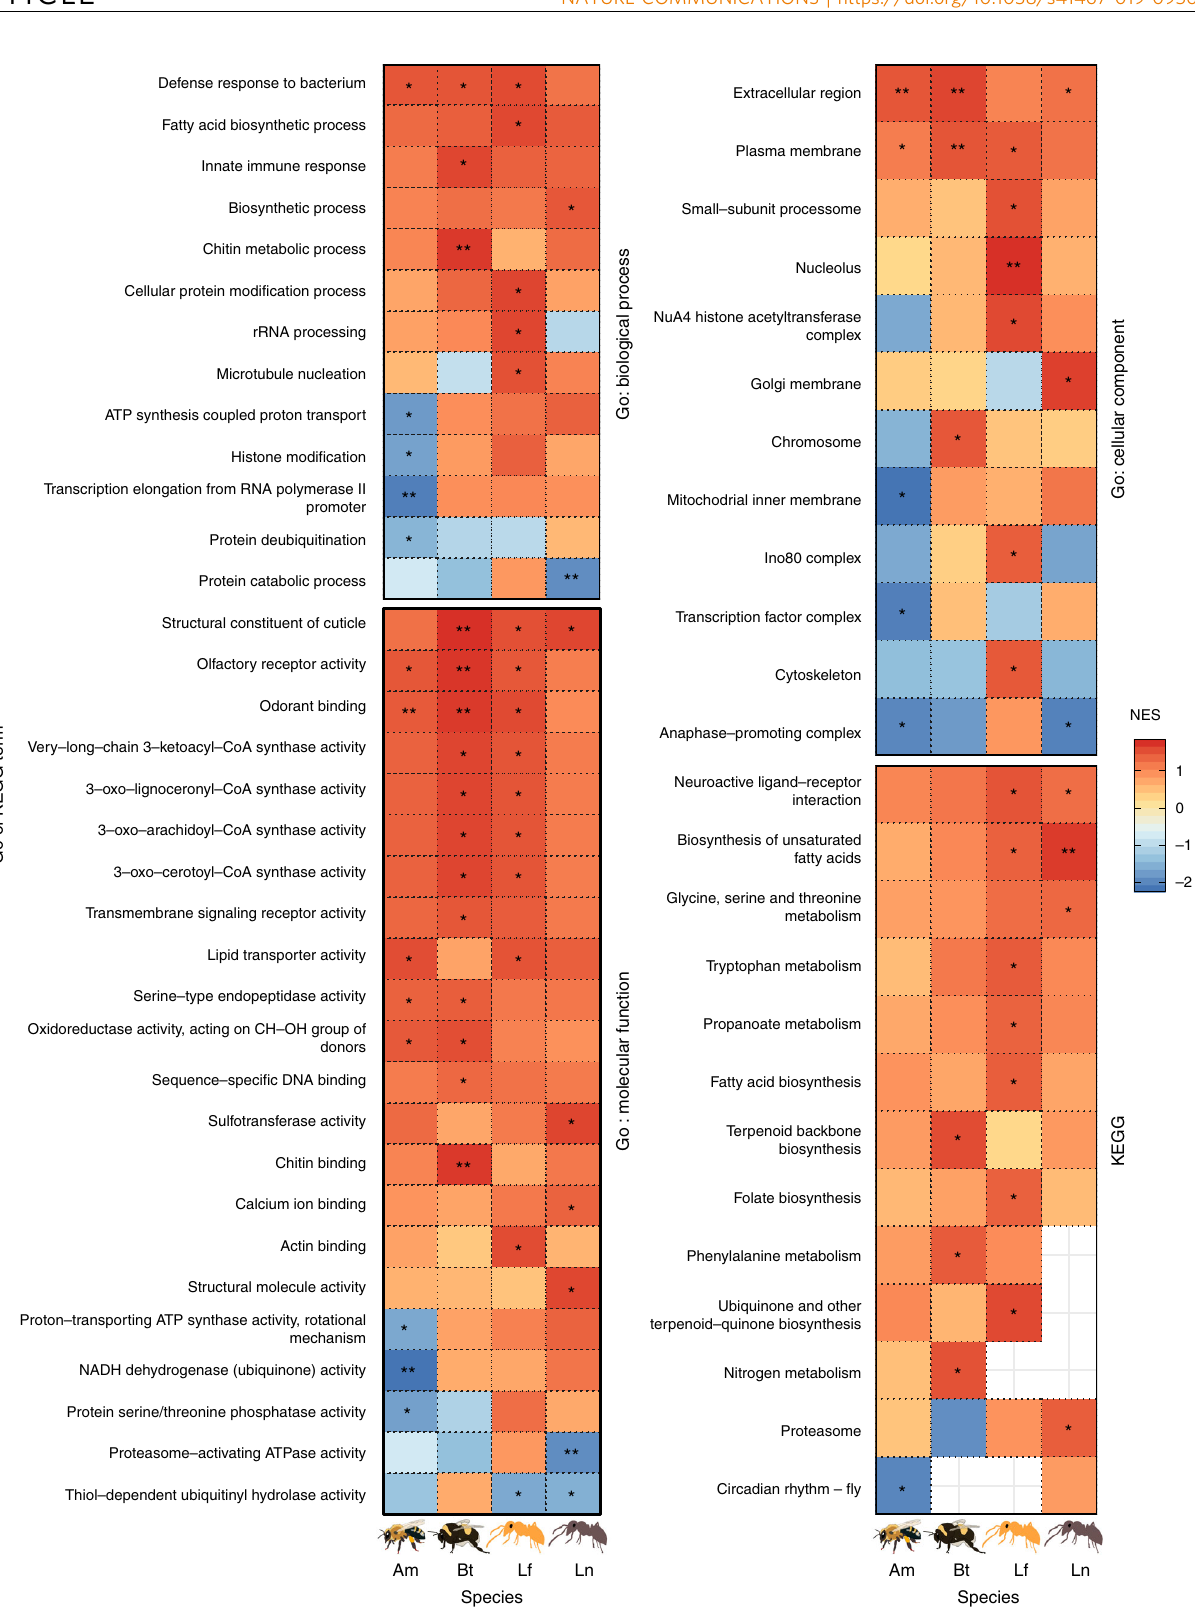
Fig. 2 Results of Gene Set Enrichment Analysis. The plot shows all Gene Ontology (GO) and Kyoto Encyclopedia of Genes and Genomes (KEGG) terms that were signi fi cantly overrepresented (red) or underrepresented (blue) among pheromone-sensitive genes in at least one of the four species. The colour shows the normalised expression score from gene set enrichment analysis. Asterisks denote statistically signi fi cant enrichment ( p < 0.05), and double asterisks mark results that remained signi fi cant after Benjamini-Hochberg correction. Empty squares denote cases where we were unable to measure expression for at least fi ve genes annotated with the focal term in one of the